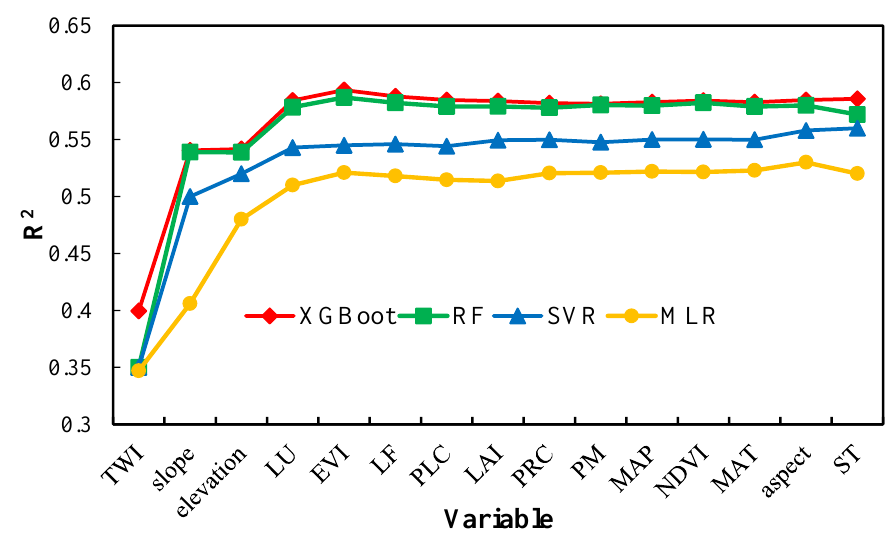
Figure 8. Variations in the coefficient of determinations for different numbers of environmental variables using MLR, SVR, RF and XGBoost.